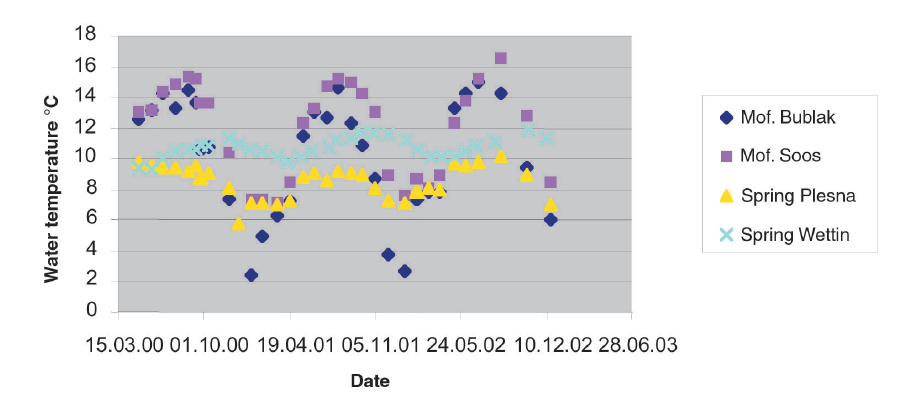
Fig. 3. Water temperature of two mofettes and two springs during 32